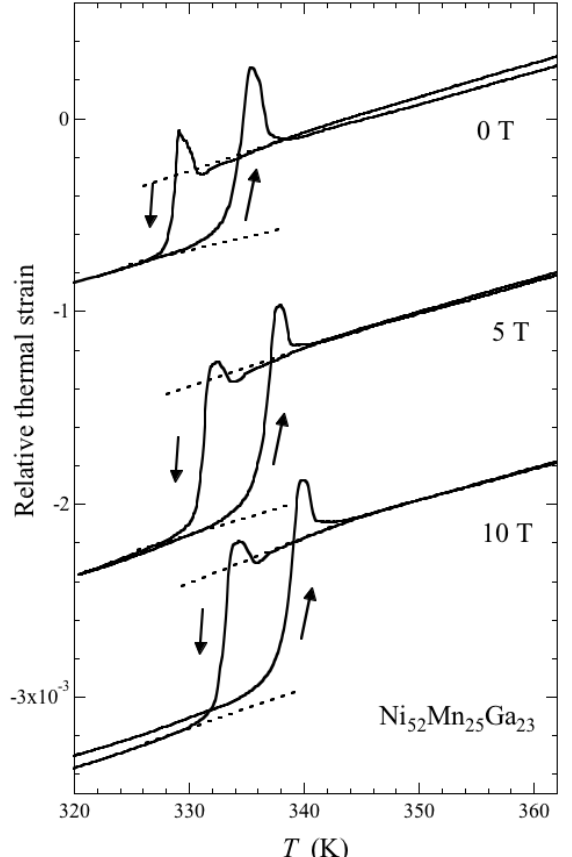
Mn Ga along the applied magnetic 52 25 23